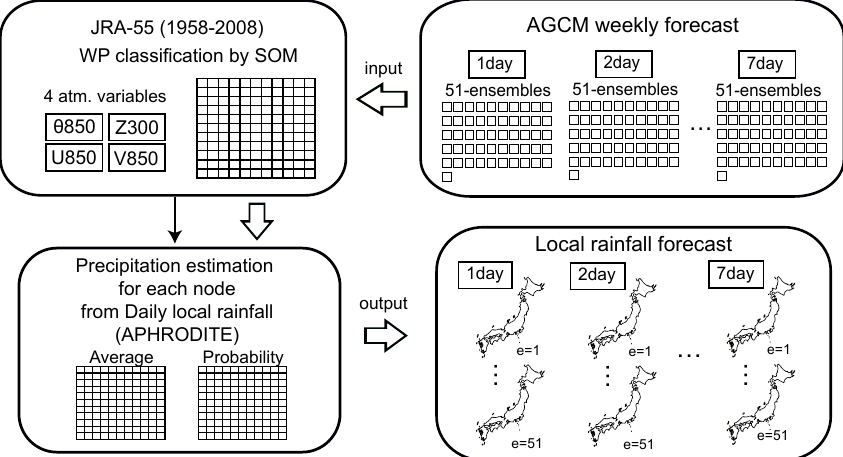
Figure 1. Schematic diagram of the SOM-based downscaling